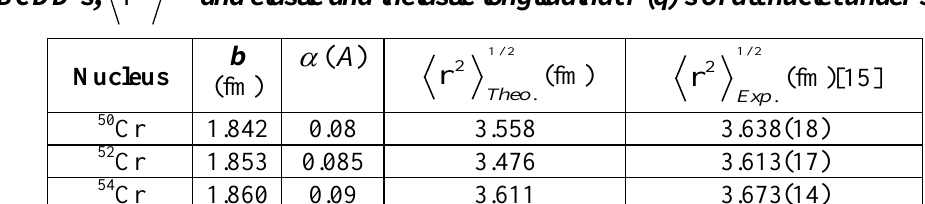
Table 1:Parameters which have been used in the calculations of the present work for the 2/1 2 r 2BCDD's, and elastic and inelastic longitudinal F(q)'s of all nuclei under study. b )( A α 2/1 .2 r (fm) Nucleus (fm) Theo 50 Cr